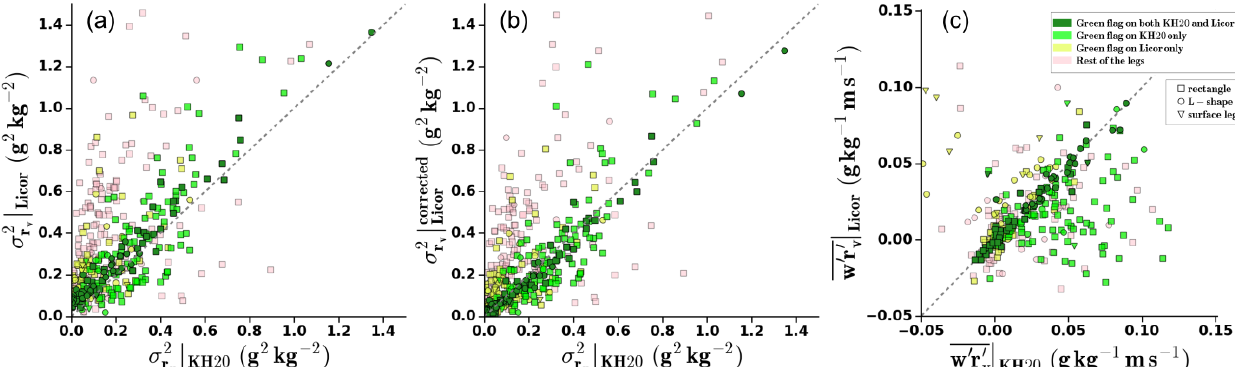
Figure 8. Humidity variances computed on 5min segments for all the flights RF03 to RF19: (a) from the KH20 signals versus the LI-COR signals and (b) from the KH20 signals versus the LI-COR signal corrected for noise. (c) Moisture flux from the KH20 signal versus from the LI-COR signal for flights RF09 to RF19. The symbols correspond to the altitude of the leg. The dark green markers refer to legs with a good-quality calibration of humidity for both sensors. Bright green markers refer to legs with a good-quality calibration of humidity for the KH20 sensor only. The yellow–green markers refer to legs with a good-quality calibration of humidity for the LI-COR sensor only. Finally, the bright pink markers correspond to the rest of the